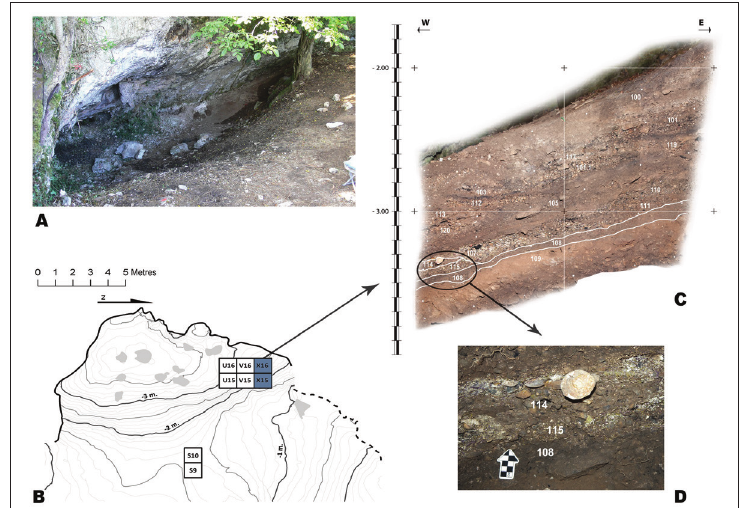
Figure 2: General view, topography and stratigraphy of the site: A) General view of the rock- shelter; B) Topographic map of the rockshelter showing excavation areas and provenance of the studied samples (shaded squares); C) Stratigraphy of the inner test pit (squares X15 and X16); D) Detailed view of stratigraphic units 108, 114 and 115.